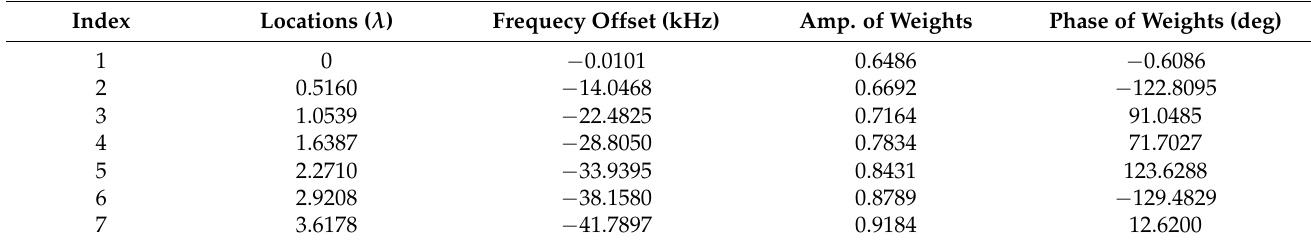
Table 2. The array positions, excitations, and frequency offsets of the obtained sparse